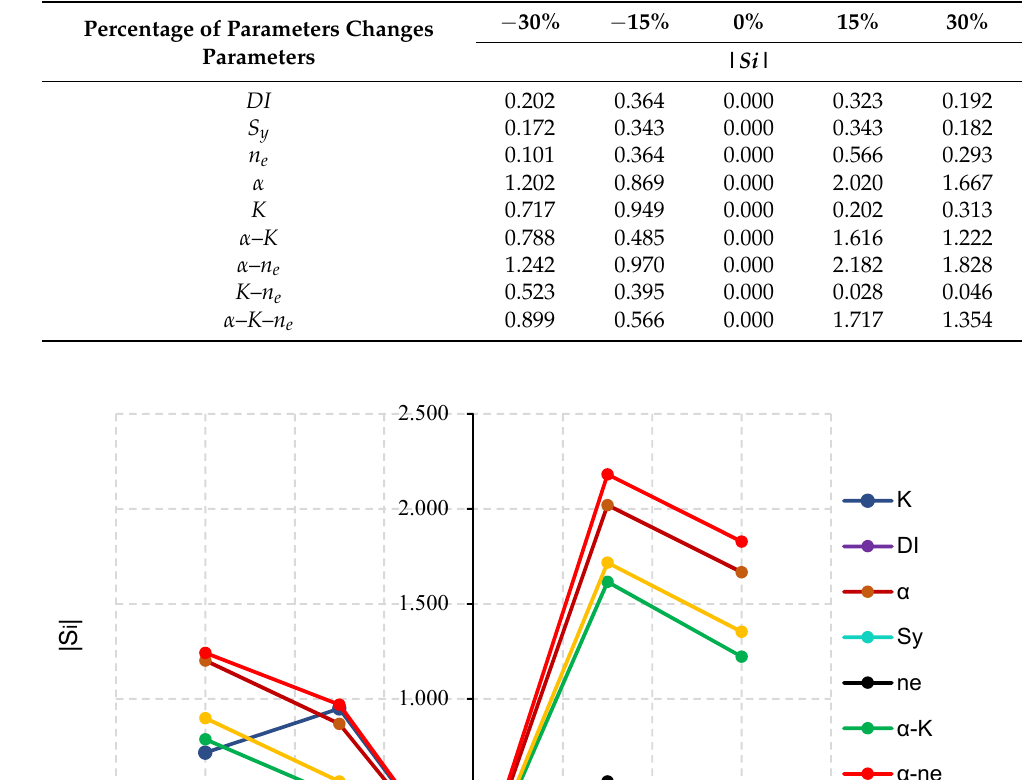
Table 8. Calculation results of parameter sensitivity.